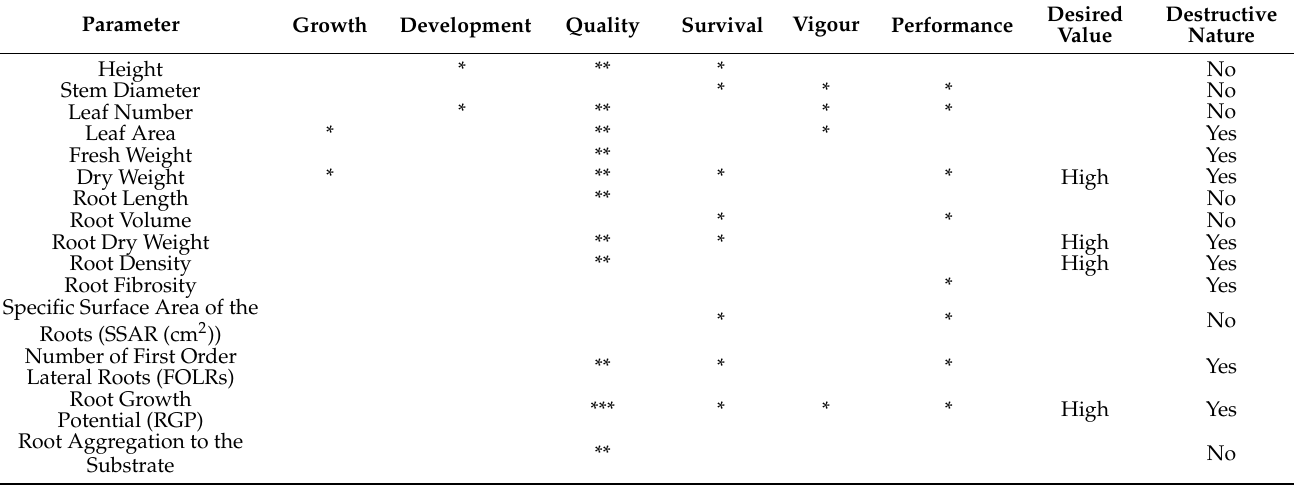
Table 2. Potential tools for prediction of growth, development, survival, vigour, plant performance, and plant quality for a rep- resentative sample of forest, fruit, horticultural, aromatic, and ornamental species ( n = 289).